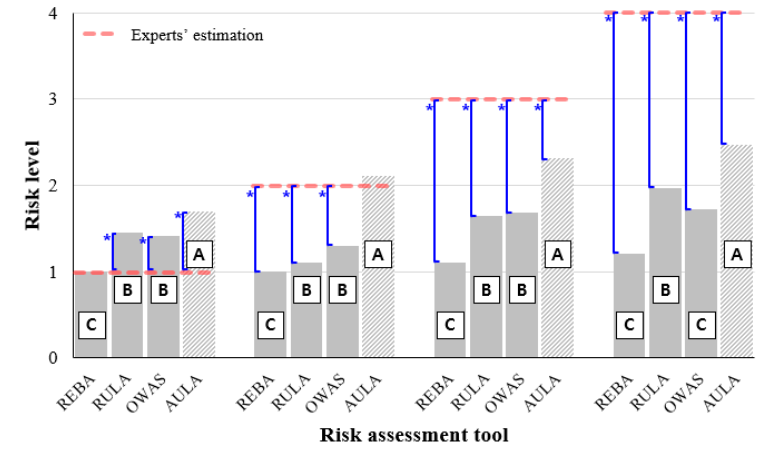
Figure 3. Results of four risk assessment tools and expert assessment (Note: * means significant difference in statistics; A, B, C, and D indicate significant grouping in statistics).